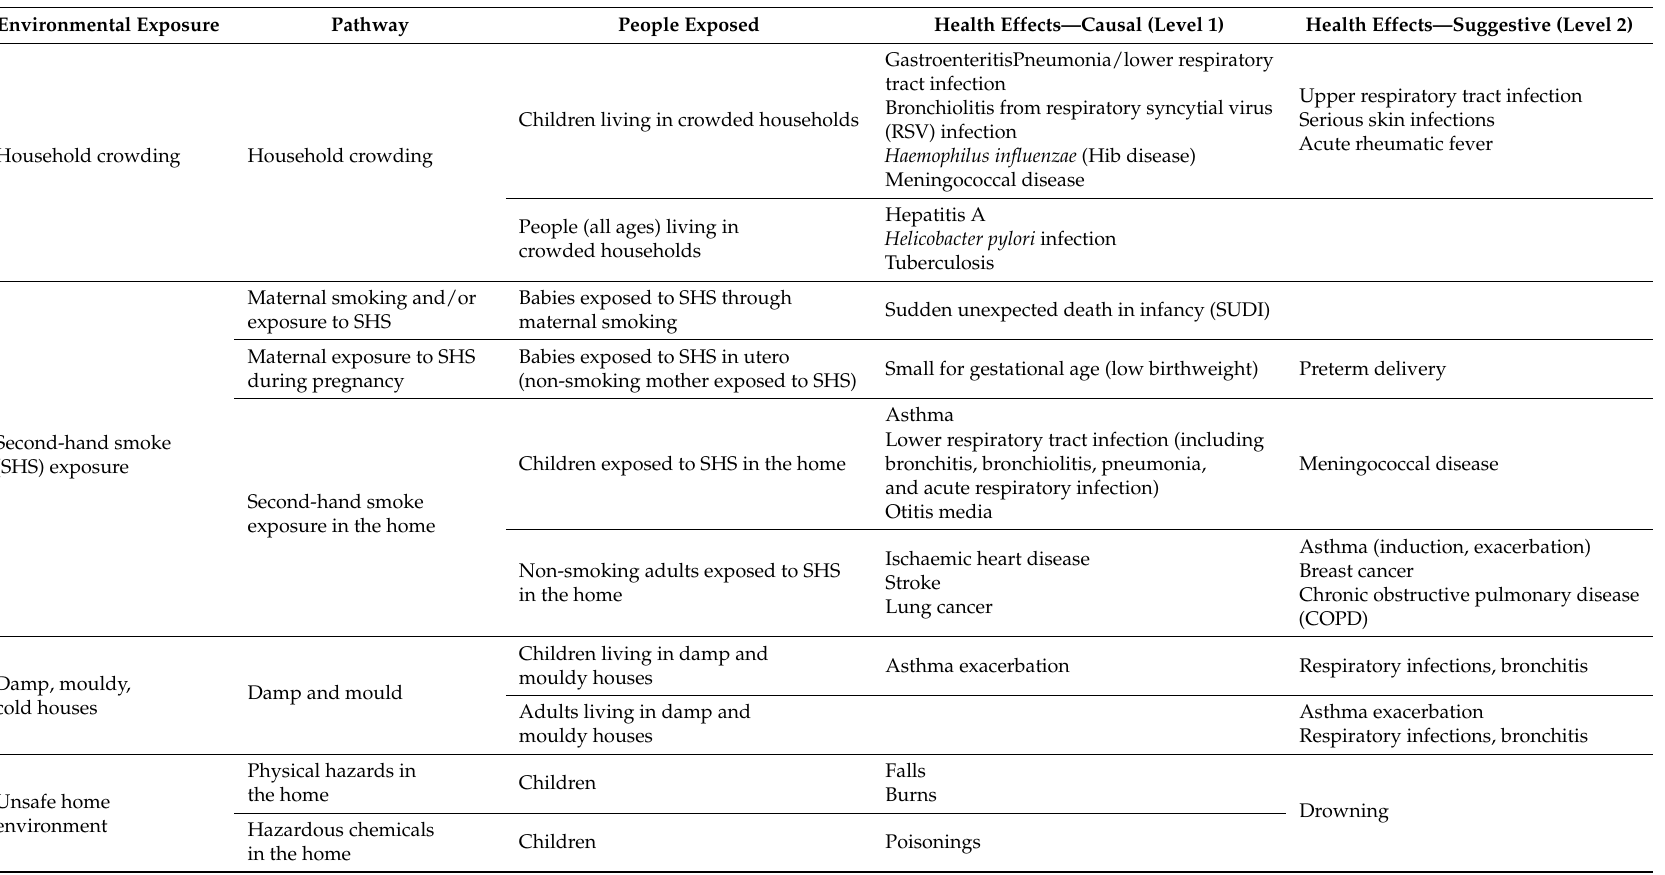
Table 3. Environmental exposures and related health effects, for the indoor